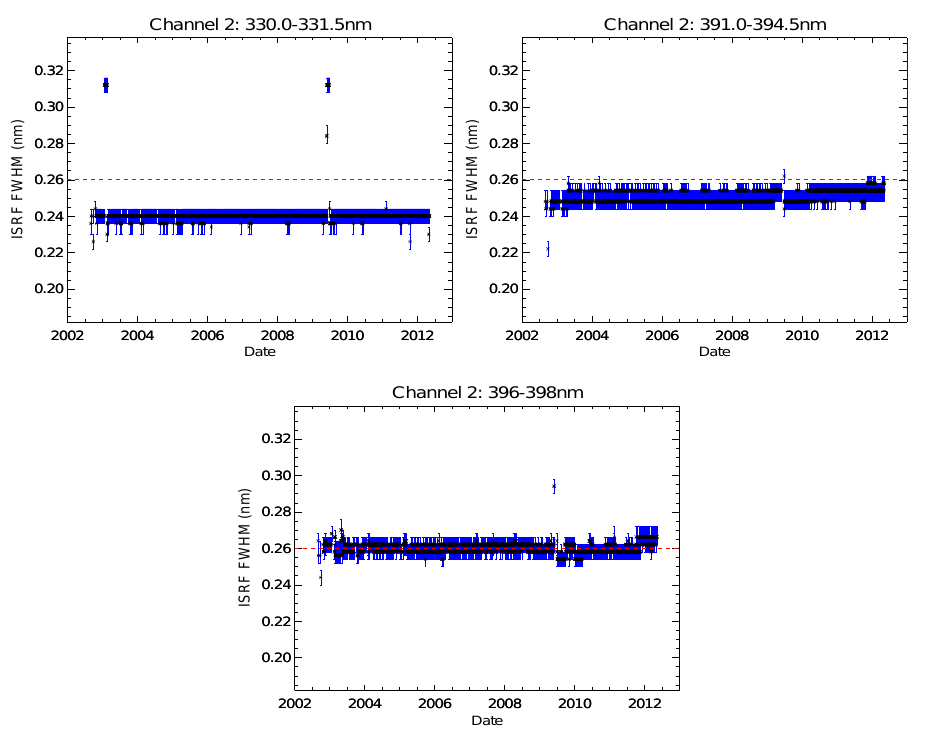
Figure 12. Similar to Figure 11 but for Channel 2. The three plots correspond to the three spectral lines from Table 4.